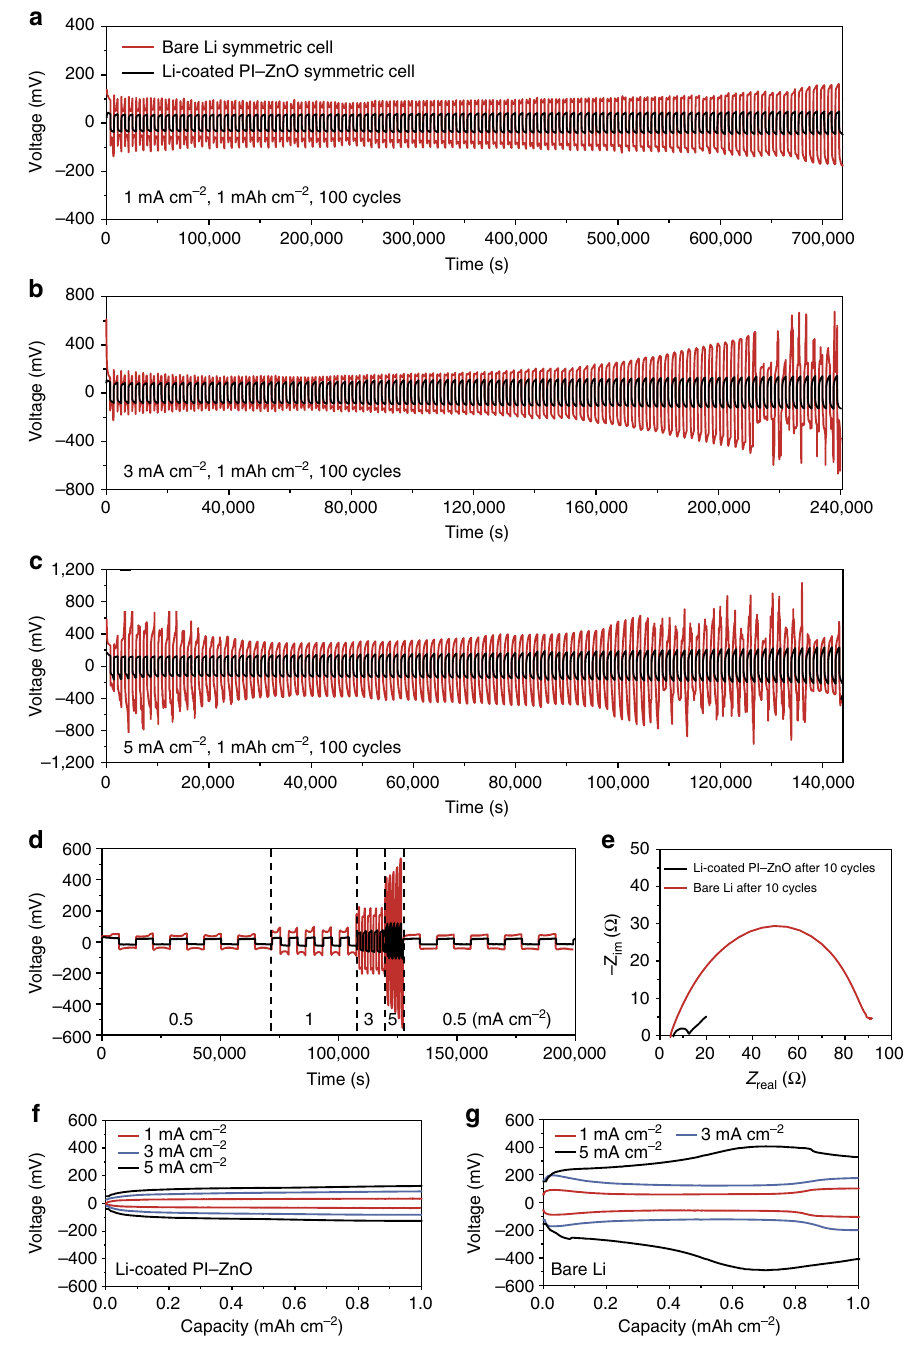
Figure 5 | Electrochemical characterization in EC/DEC electrolyte. Comparison of the cycling stability of the Li-coated PI matrix and the bare Li electrode at a current density of ( a ) 1mAcm (cid:2) 2 , ( b ) 3mAcm (cid:2) 2 and ( c ) 5mAcm (cid:2) 2 . ( d ) Rate performance of the Li-coated PI matrix and the bare Li electrode. ( e ) Nyquist plot of the impedance spectra of the symmetrical Li-coated PI matrix and the bare Li cell after 10 cycles at a current density of 1mAcm (cid:2) 2 . Voltage profiles of ( f ) Li-coated PI matrix and ( g ) bare Li electrode at different current densities after 10 cycles. The amount of Li cycled was 1mAhcm (cid:2) 2 in all